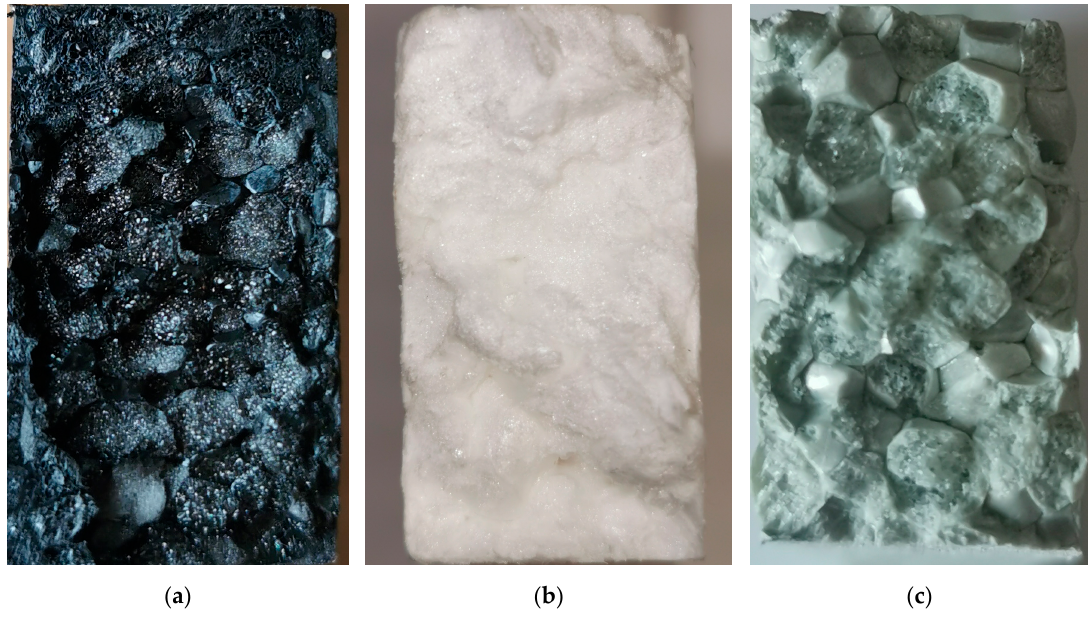
Figure 9. Fracture surfaces of the bead foam parts in tensile load for ( a ) EPP, ( b ) EPC, and ( c )